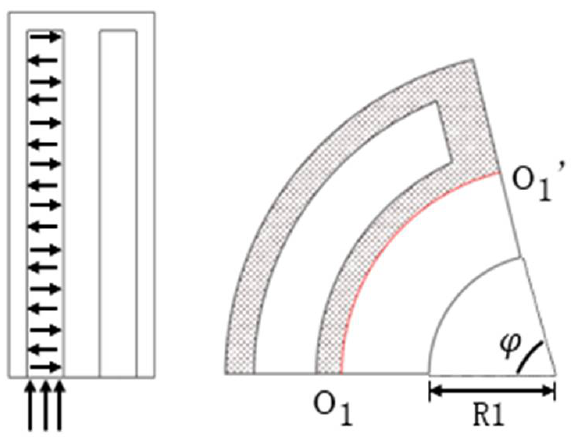
Figure 4. The bend of proximal phalangeal joint. The movement principle of the middle/distal phalanx joint is shown in Figure 5. The middle phalanx joint is composed of four air chambers (the distal phalanx joint is composed of three air chambers, and the structure is similar to that of the middle phalanx joint). When the soft body moves like a human finger, the positive pressure gas flows into the gas chamber. The flexural motion of the phalangeal joint is generated by anisotropic deformation by utilizing the expansion of the air cavity of the finger joint and the asymmetry of the bionic finger structure.